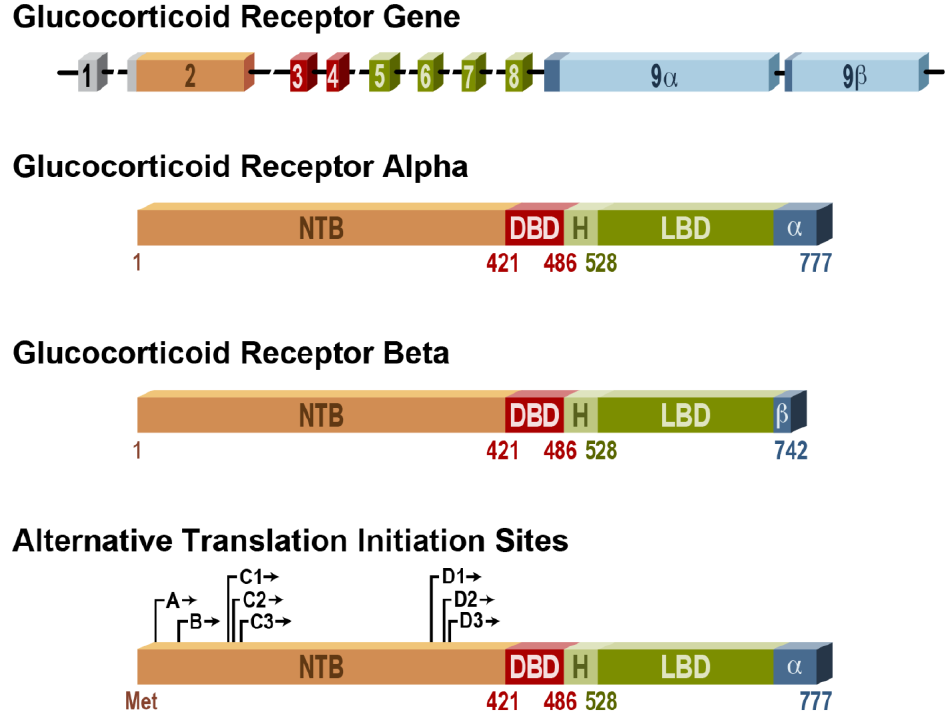
Figure 1. Glucocorticoid Receptor (GR) Gene